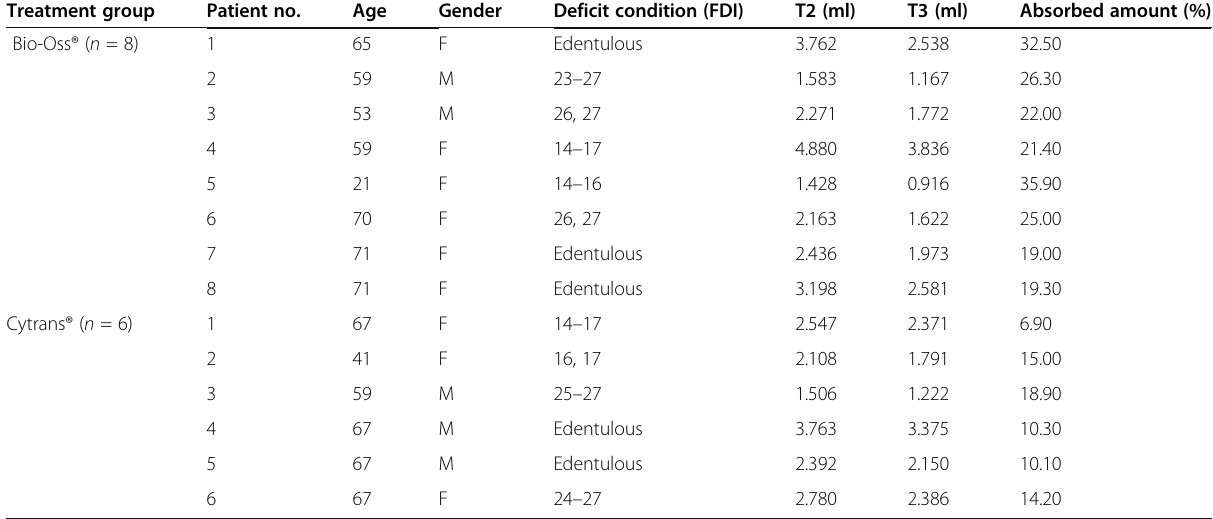
Table 1 Clinical data on the volume of bone-filling material in procedures using Bio-Oss® and Cytrans® Treatment group Patient